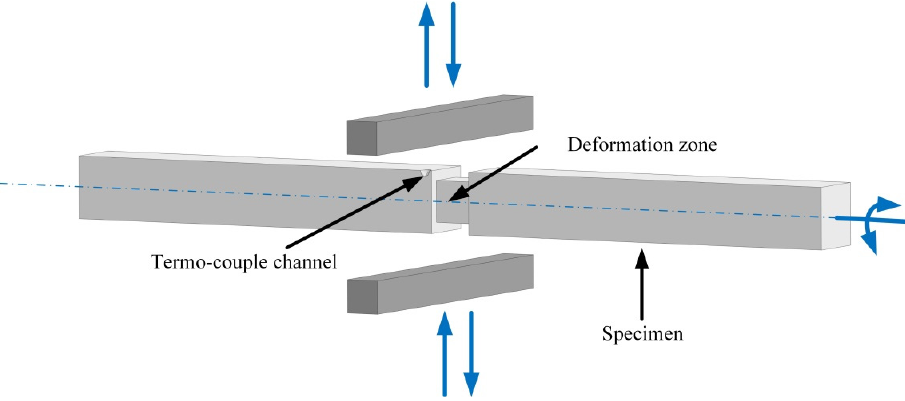
Figure 1. Deformation scheme on the MaxStrain module.